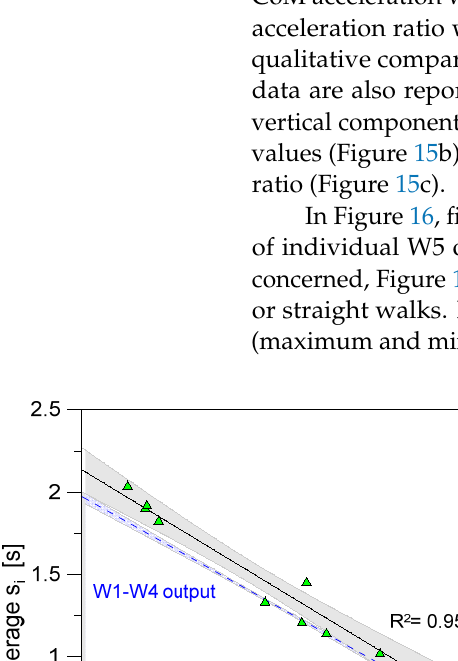
Figure 15. Summary of experimental records for W5 configurations (10 in total, SLAB#1), as a func- tion of calculated walking frequency: ( a ) peak of vertical acceleration, ( b ) average vertical accelera- tion, ( c ) peak-to-peak versus maximum acceleration. The 95% confidence interval is shown in grey colour. Table 4. Analysis of W5 vertical acceleration data (SLAB#1, 10 samples), with standard deviation in brackets and correlation coefficient R .